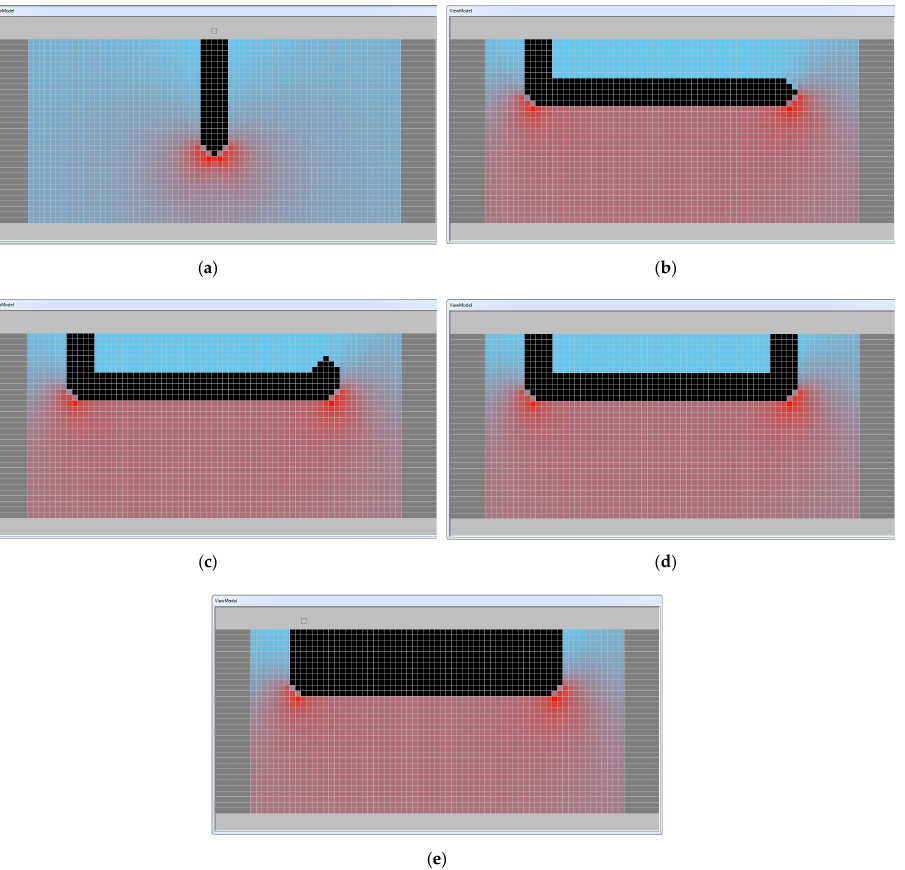
Figure 9. Current distribution for simple cut types represented as a gradient fill: ( a ) I-cut; ( b ) L-cut; ( c ) J-cut; ( d) U-cut; ( e ) S-cut. Electronics 2023 , 12 , 589